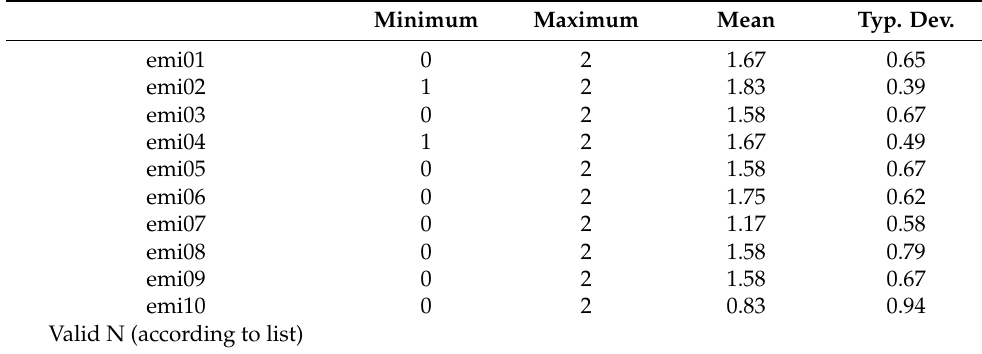
Table 1. Descriptive statistics for the EMI items.